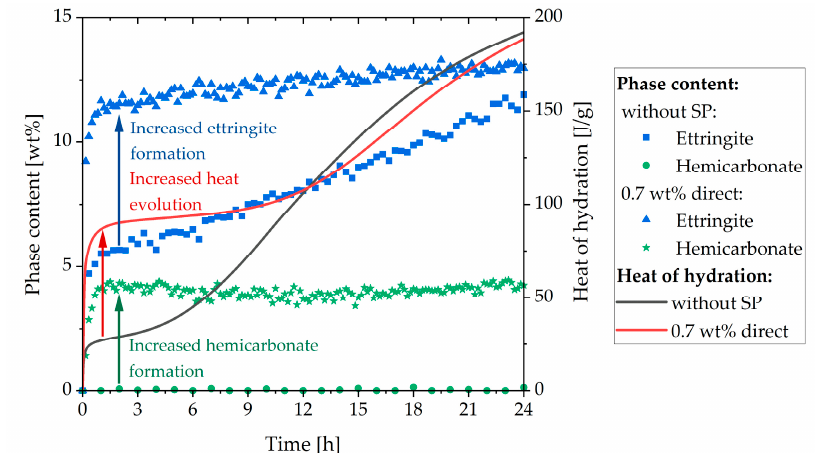
Figure 14. Ettringite and hemicarbonate content of the sample without SP and with direct addition of 0.7 wt% of SP and the heat evolution of both samples. 0.7 wt% of SP and the heat evolution of both